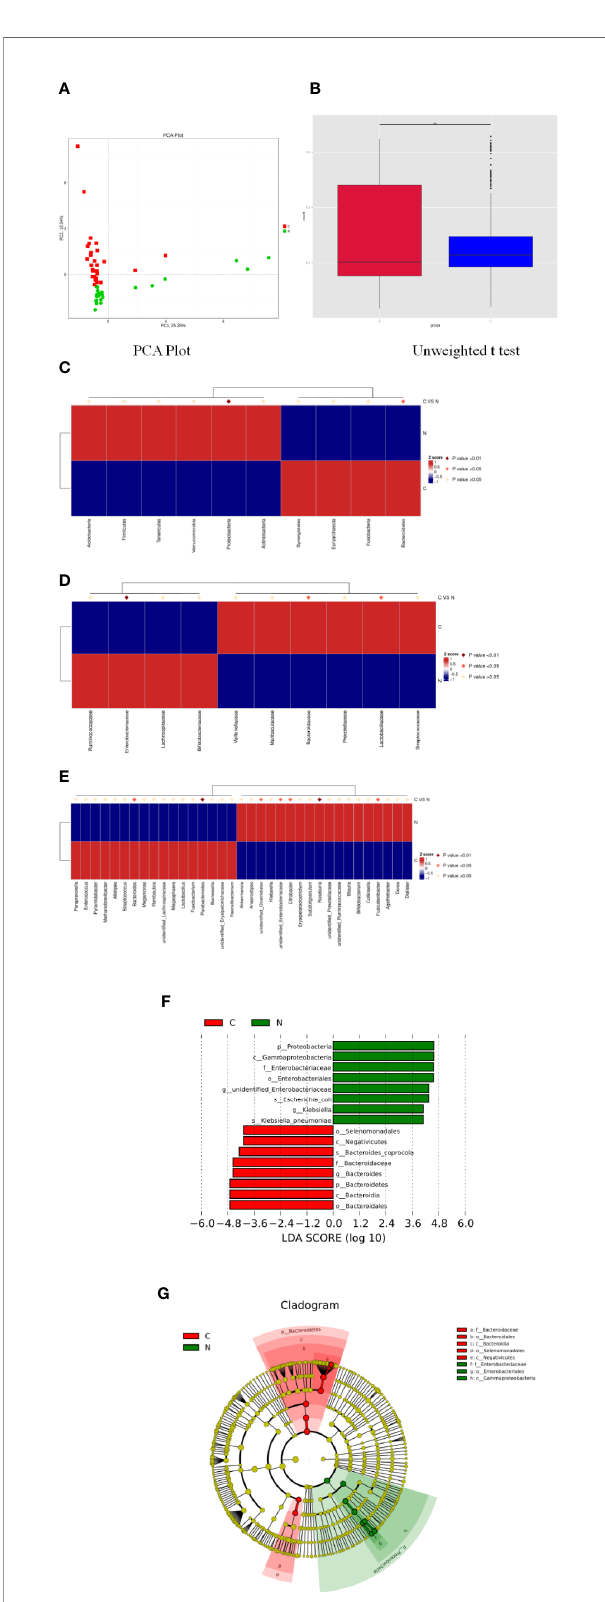
FIGURE 3 | Signi fi cant differences in fecalmicrobiota between constipated women of reproductive age andhealthycontrol subjects. (A) Principal component analysis of the two groups. (B) Box plots ofbeta diversity. (C) Comparisonofthe top10 phyla. (D) Comparison of the top10 families. (E) Comparisonofthe top 35 genus. (F) Distribution of LDA values displayed as a histogram,with an LDA value of>4 indicatingstatistical signi fi cance between the two groups. (G) Phylogenetic distribution of the microbiome of the